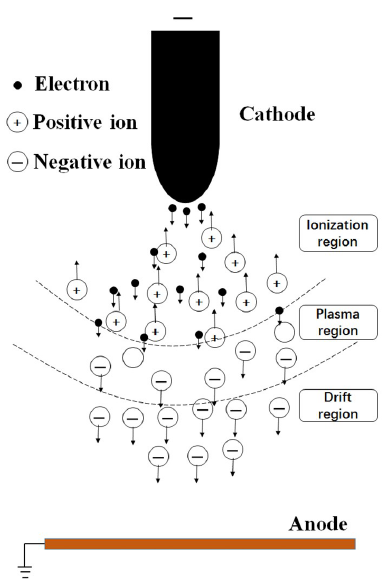
Figure 9. Negative corona discharge region division.